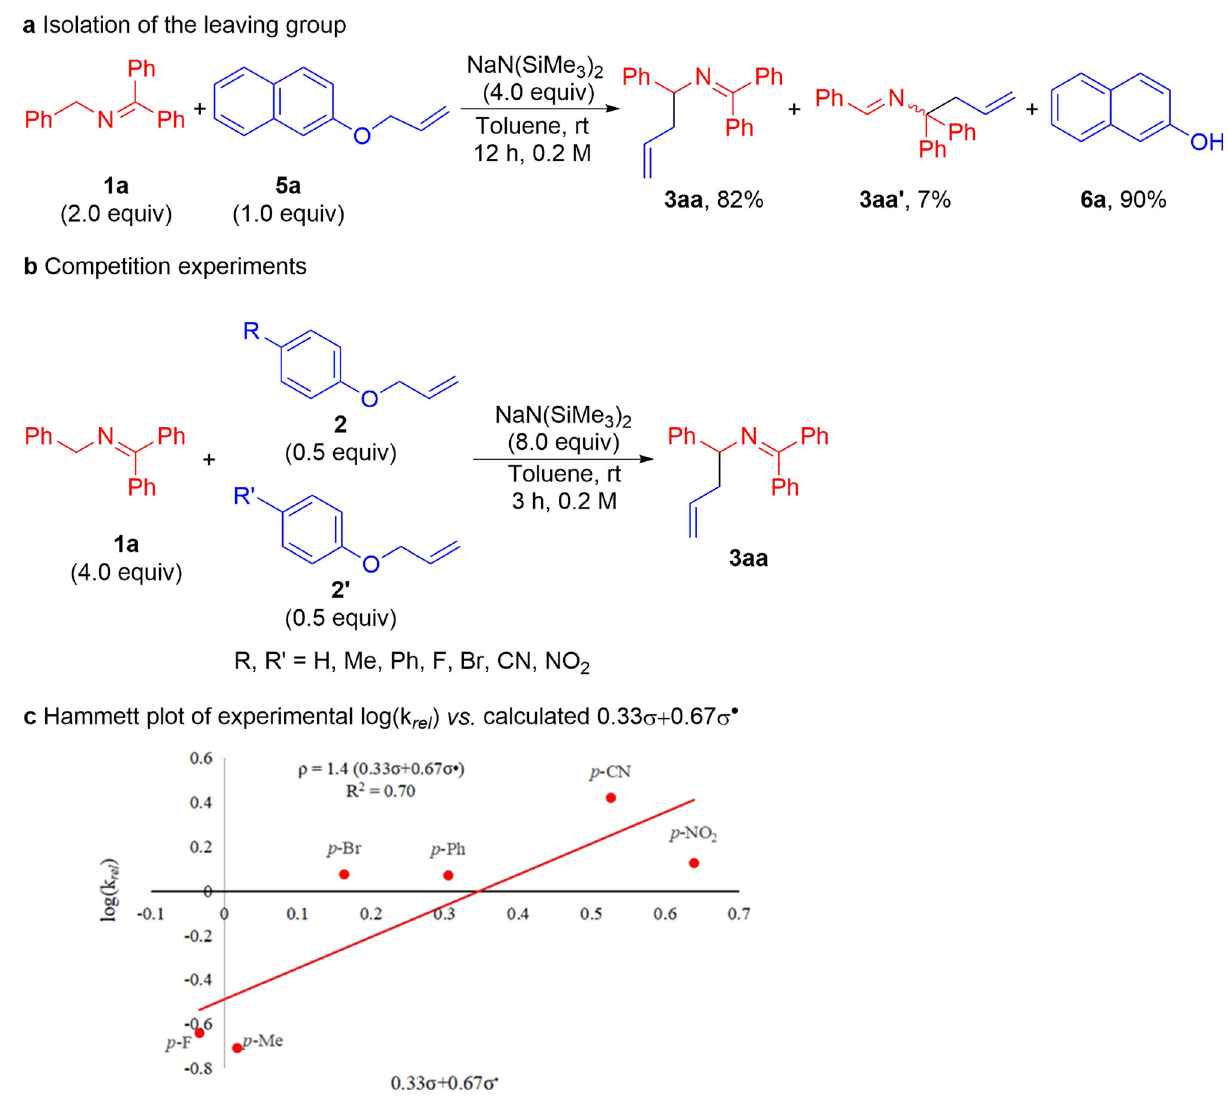
Fig. 6 Mechanistic probes. a Isolation of the leaving group. b Competition experiments. c Plot of log( k rel ) versus a combination of σ (33%) and σ • (67%). Scatter in the plot is likely due to mixed